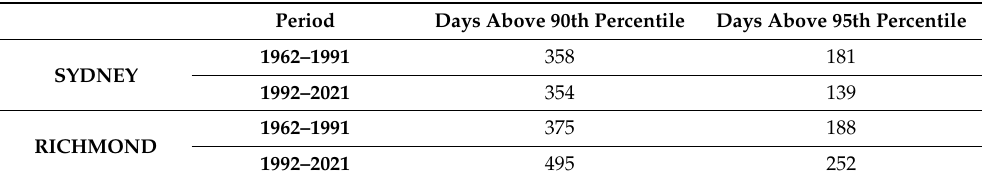
Figure 5. Number of days above the ( a ) 90th percentile and ( b ) 95th percentile across the time series for Richmond. The red outlined box denotes the percentile value that is used as the baseline marker and the dotted red line splits the two climate periods.